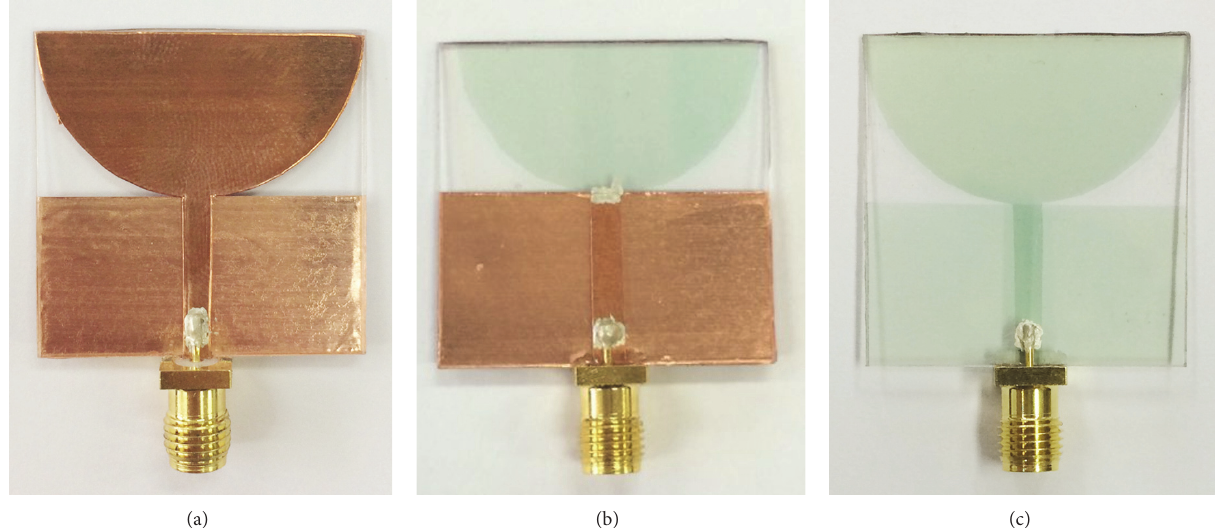
Figure 2: Fabricated antennas with copper sheet and transparent conductive films. (a) CUWB. (b) TRUWB. (c) TUWB.